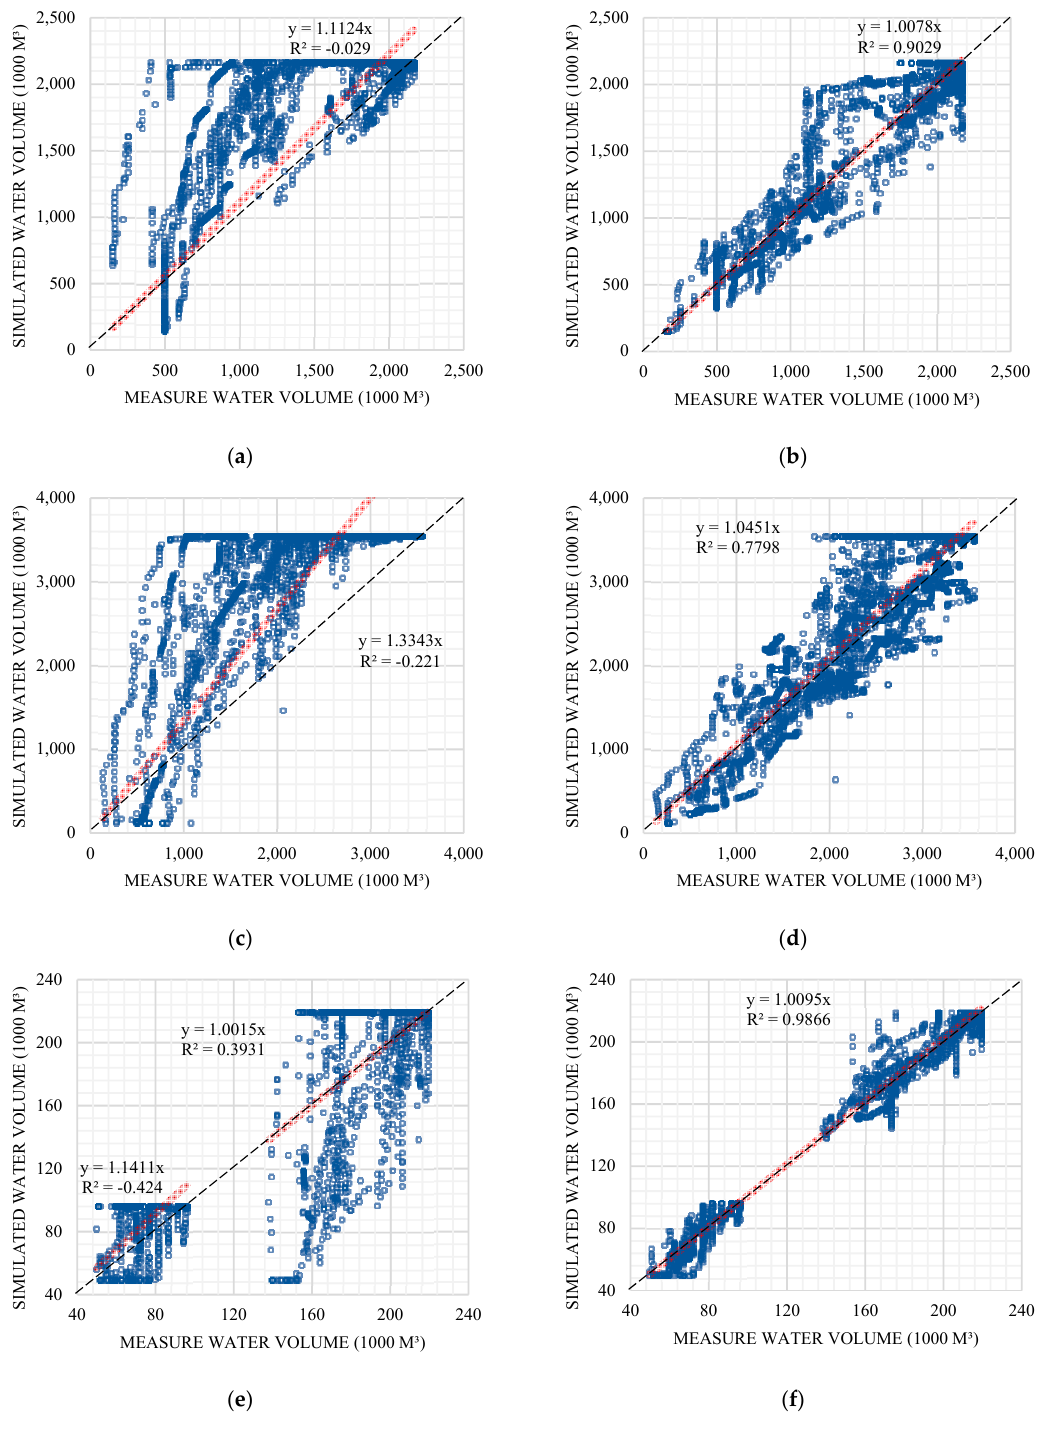
Figure 7. Comparison of measured and simulated reservoir water volume in the Kicheon, Deokwoo, and Samchun reservoirs to evaluate the accuracy of RCF calibration. ( a ) Before calibration (Kicheon reservoir); ( b ) after calibration (Kicheon reservoir); ( c ) before calibration (Deokwoo reservoir); ( d ) after calibration (Deokwoo reservoir); ( e ) before calibration (Samchun reservoir); ( f ) after calibration (Samchun reservoir).